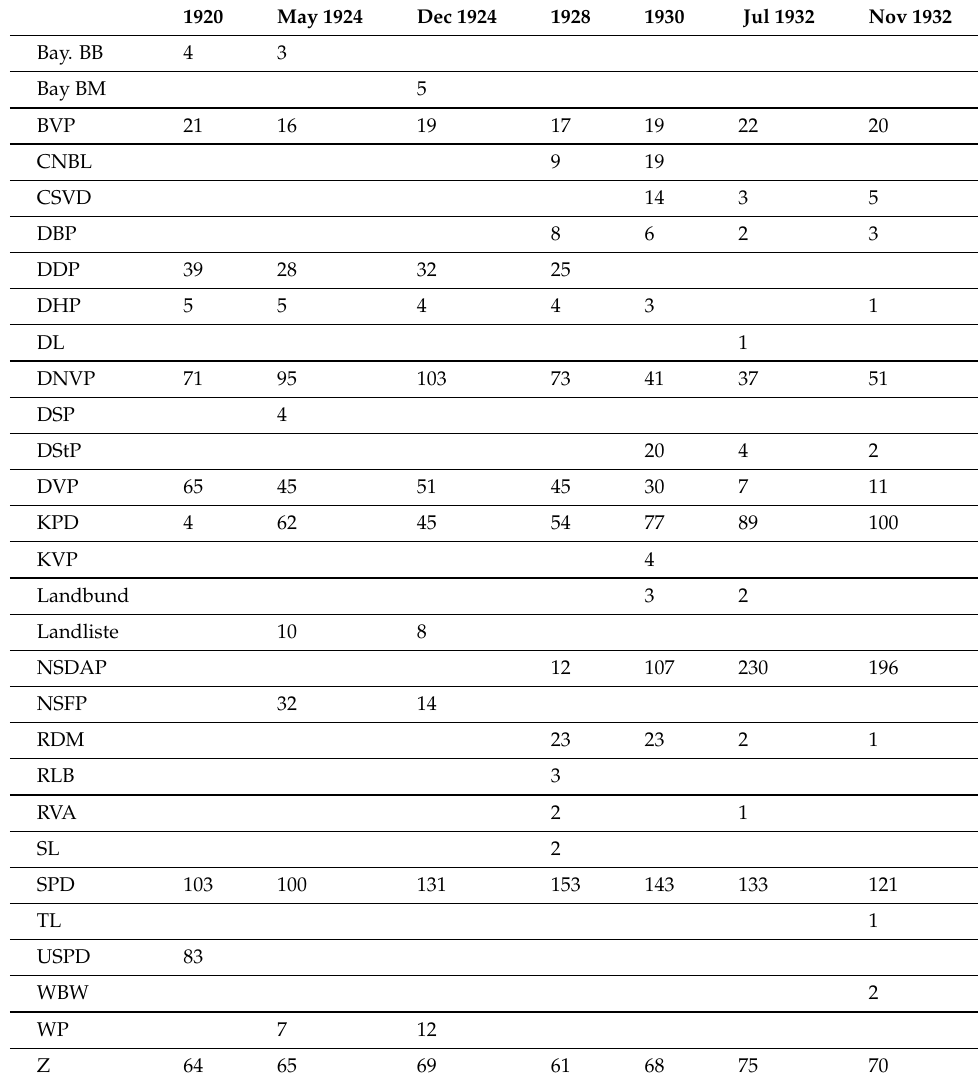
Table 7. Weimar Republic parliament,